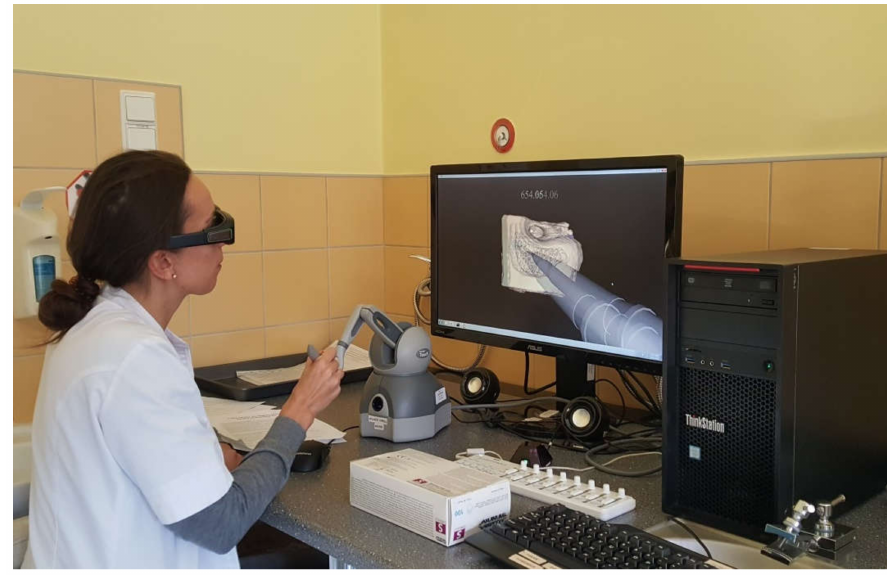
Figure 2. Virtual reality (VR) temporal bone